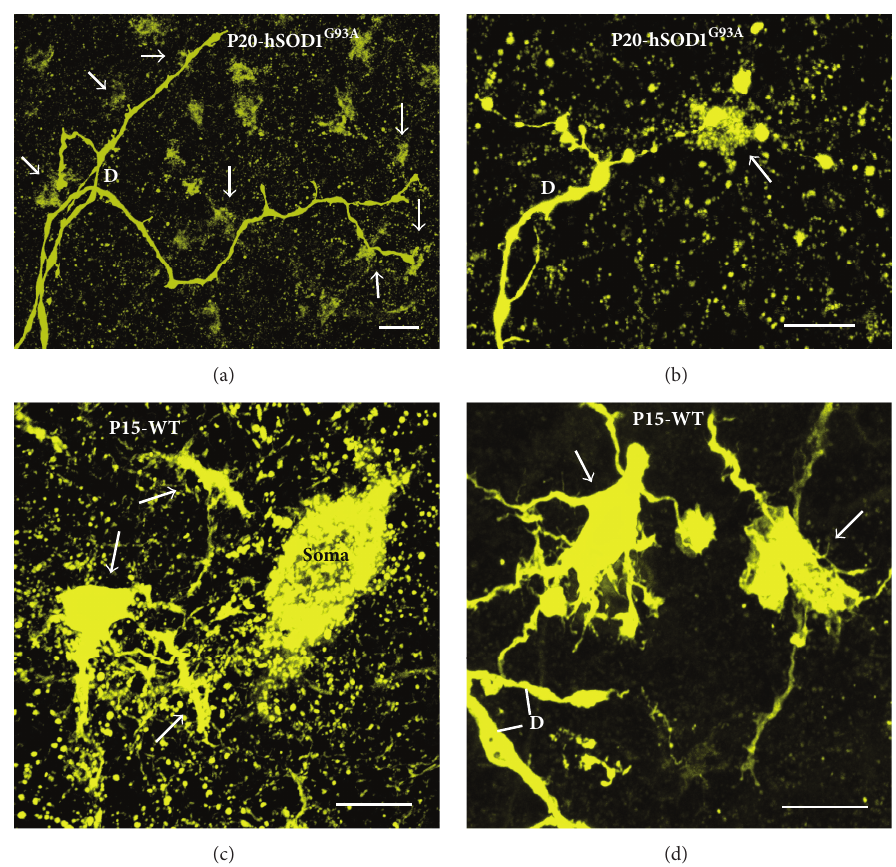
Figure 9: Microglial control of motoneuronal territory. Microglia were indirectly labeled by Neurobiotin, which they engulfed by phagocytosis from Neurobiotin-filled motoneurons, evident from detection of Neurobiotin both in dye-filled motoneuron and microglia. Neurobiotin was visualized by incubating brain slices in Streptavidin Cy3, as usual (standard) in all our preparations presented in this study (for details see Kanjhan and Vaney, 2008 [25], and Kanjhan and Bellingham, 2013 [26]). (a) A mosaic of activated microglia (arrows; with amoeboid appearance and loss of stellate processes) seen in close contact to the Neurobiotin-filled distal dendrites of a hypoglossal motoneuron in a brain slice from a P20 mice overexpressing the mutated human SOD 1 G 93 A gene. (b) An example of resident microglia (arrow) engulfing distal dendrites (D) of a dye-filled hypoglossal motoneuron from hSOD 1 G 93 A mutant mouse, as indicated by the blebbing of the dendrite and that both dendrite and microglia contain Neurobiotin. (c-d) Resident microglia (arrows), activated by blocking inhibitory synaptic transmission by addition of 5 𝜇 M bicuculline and 2 𝜇 M strychnine for > 15 minutes, engulfing the soma (c) and dendrites (d) of a dye-filled hypoglossal motoneuron in brainstem slices from P15 WT mice. Bright appearance of microglia is due to Neurobiotin taken by phagocytosis from the soma and dendrites of motoneuron. Note swelling, beading, blebbing, and vacuolization in soma (c), dendrites (b, d), and spines (b). Scale bars = 10 𝜇